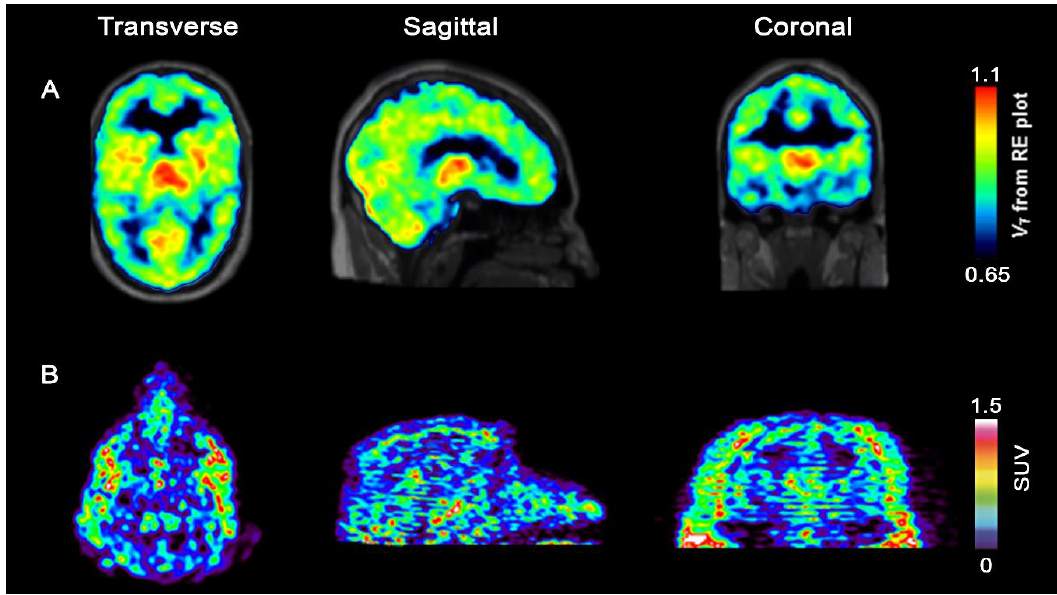
Figure 7. Upper row: PET/T1MP-RAGE MRT in vivo overlay images of [ 11 C]-(R)-12 in a human subject with high SUVs in TrkB/C rich compartments such as thalamus, followed by cerebellum and cortical grey matter and low uptake in Trk devoid white matter areas; Bottom row: In vivo PET images of [ 18 F]-(R)-13 (high A m of 245 GBq/µmol) in rhesus monkey brain matching the expected TrkB/C distribution.